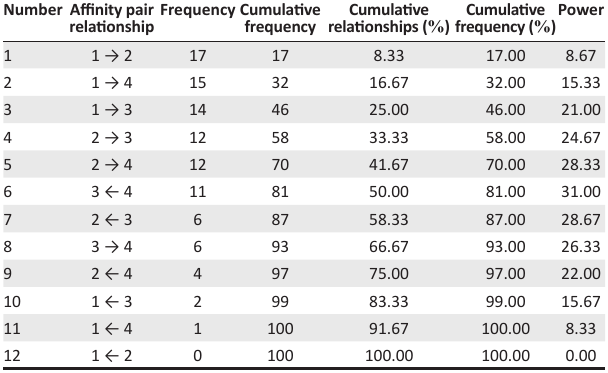
TABLE 2: Tabular inter-relationship diagram. Affinity Number